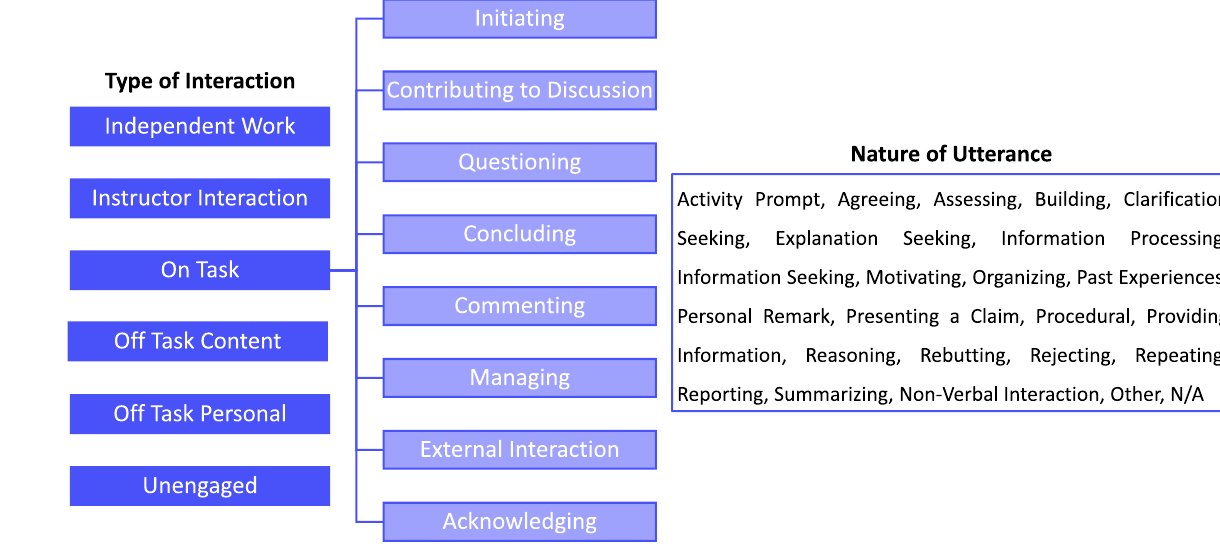
Fig. 1 Student Interaction Discourse Moves three-tiered analytical framework